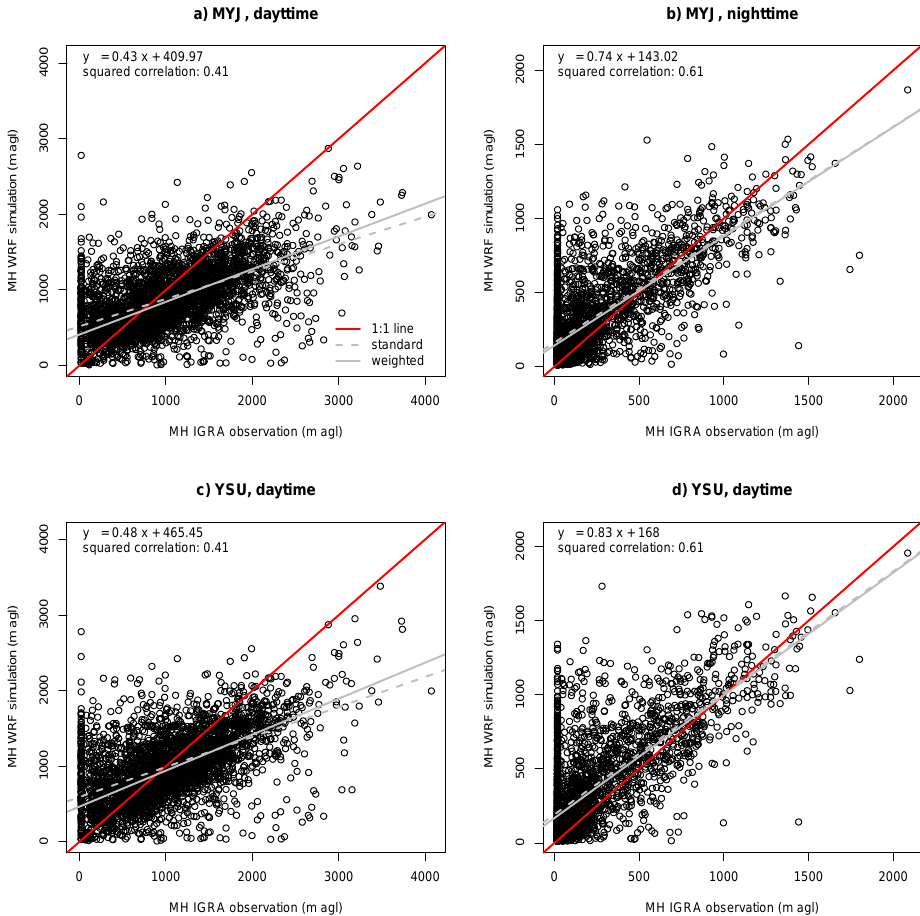
Figure 4. Comparison of WRF- and IGRA-derived MHs using the Ri method. We used about 6700 samples almost evenly distributed among day and night (00:00 and 12:00UTC). The left column (a, c) shows 12:00UTC and the right column (b, d) 00:00UTC data. The function of a weighted linear regression model together with the resulting r 2 is shown in the upper left corner of each plot (dashed grey line). The weights were set to the reciprocal of the MH estimation uncertainty. The regression function neglecting this uncertainty is indicated as a solid grey line. The squared correlation coefficients for the latter are shown in Table